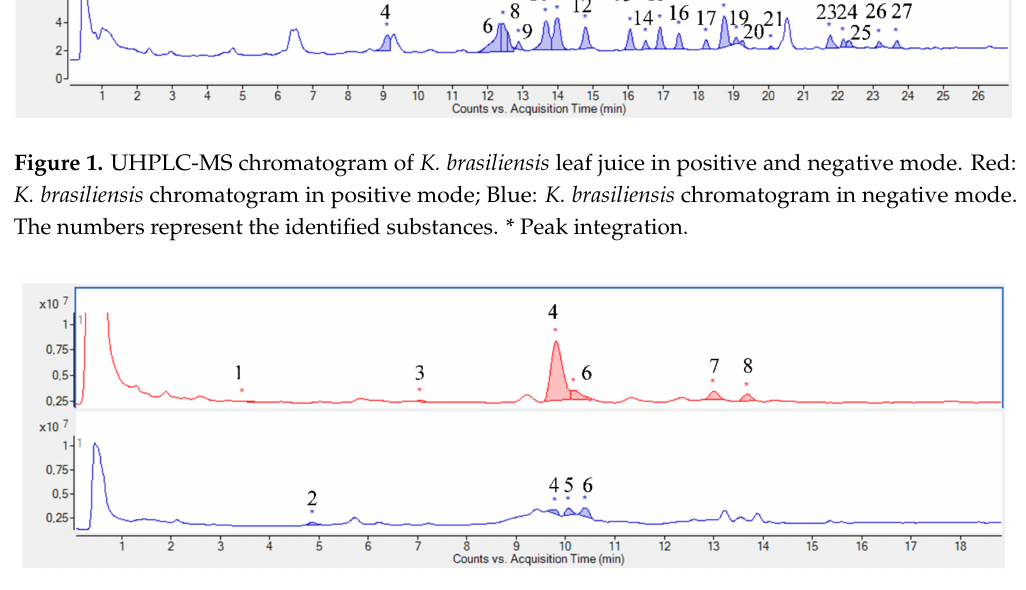
Figure 2. UHPLC-MS chromatogram of K. pinnata leaf juice in positive and negative mode. Red: K. pinnata chromatogram in positive mode; Blue: K. pinnata chromatogram in negative mode. The numbers represent the identified substances. * Peak